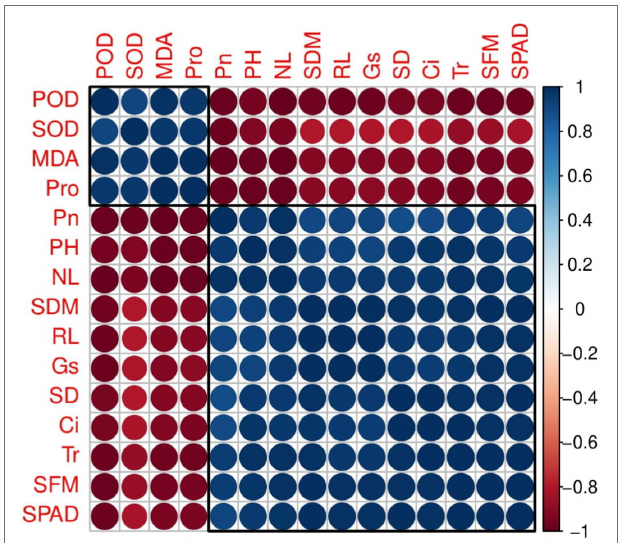
FIGURE 4 | Correlation of different studied parameters in industrial hemp. Different abbreviations used in the figure are as follows: SFM, shoot fresh weight; SDM, shoot dry weight; NL, number of leaves per plant; PH, plant height; SD, stem diameter; RL, root length, SPAD, Chlorophyll; P n, net photosynthesis; G s, stomatal conductance; T r, transpiration rate; C i , intercellular CO 2 concentration; SOD, superoxide dismutase; POD, peroxidase; MDA, malondialdehyde; Pro, proline.